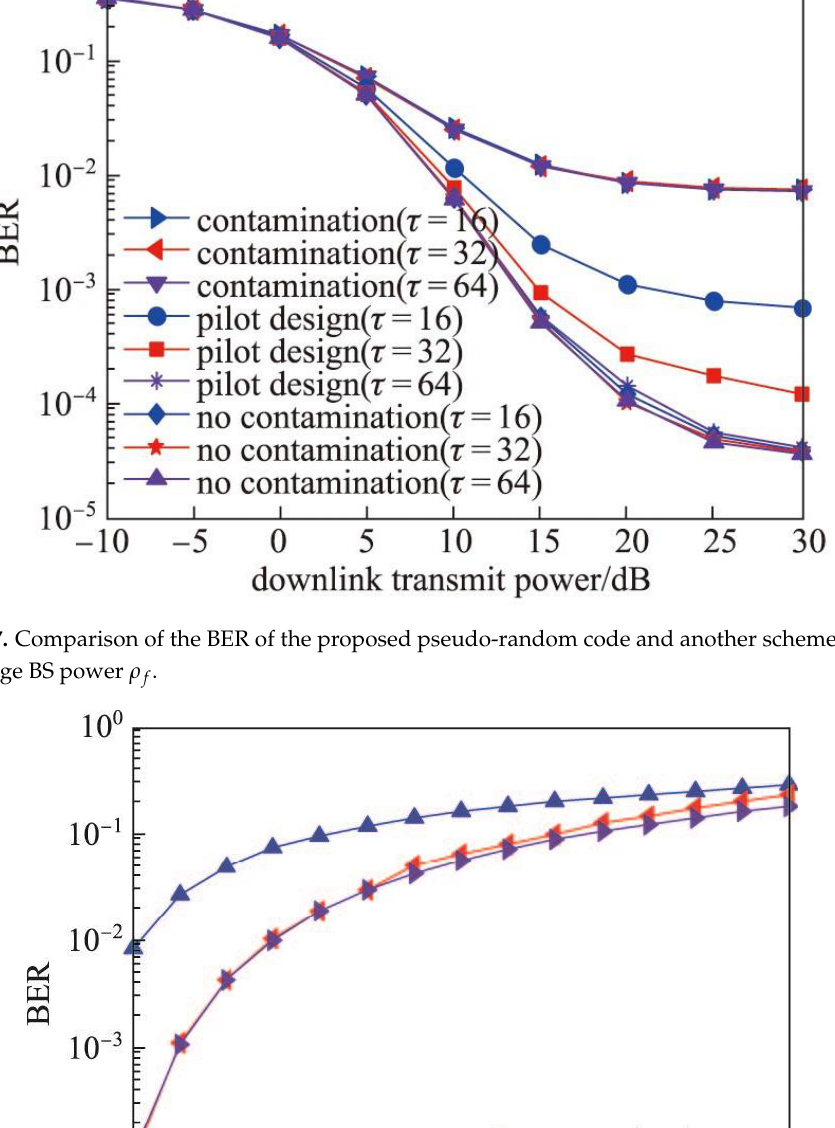
Figure 19. NMSE comparison of IPLUG and conventional algorithms.